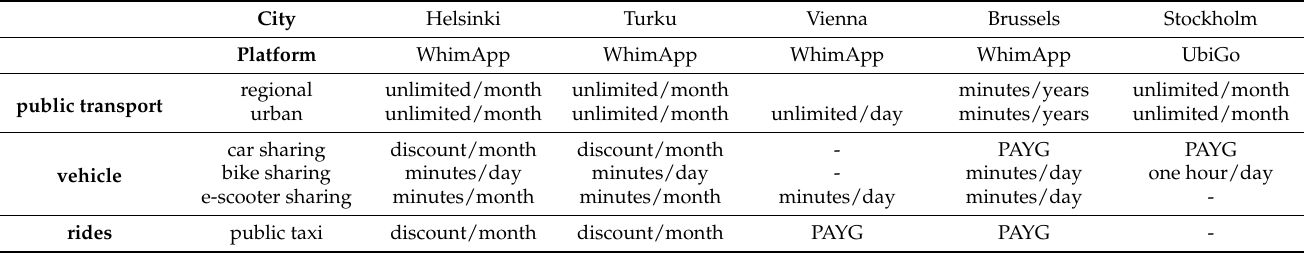
Table 1. Some examples of